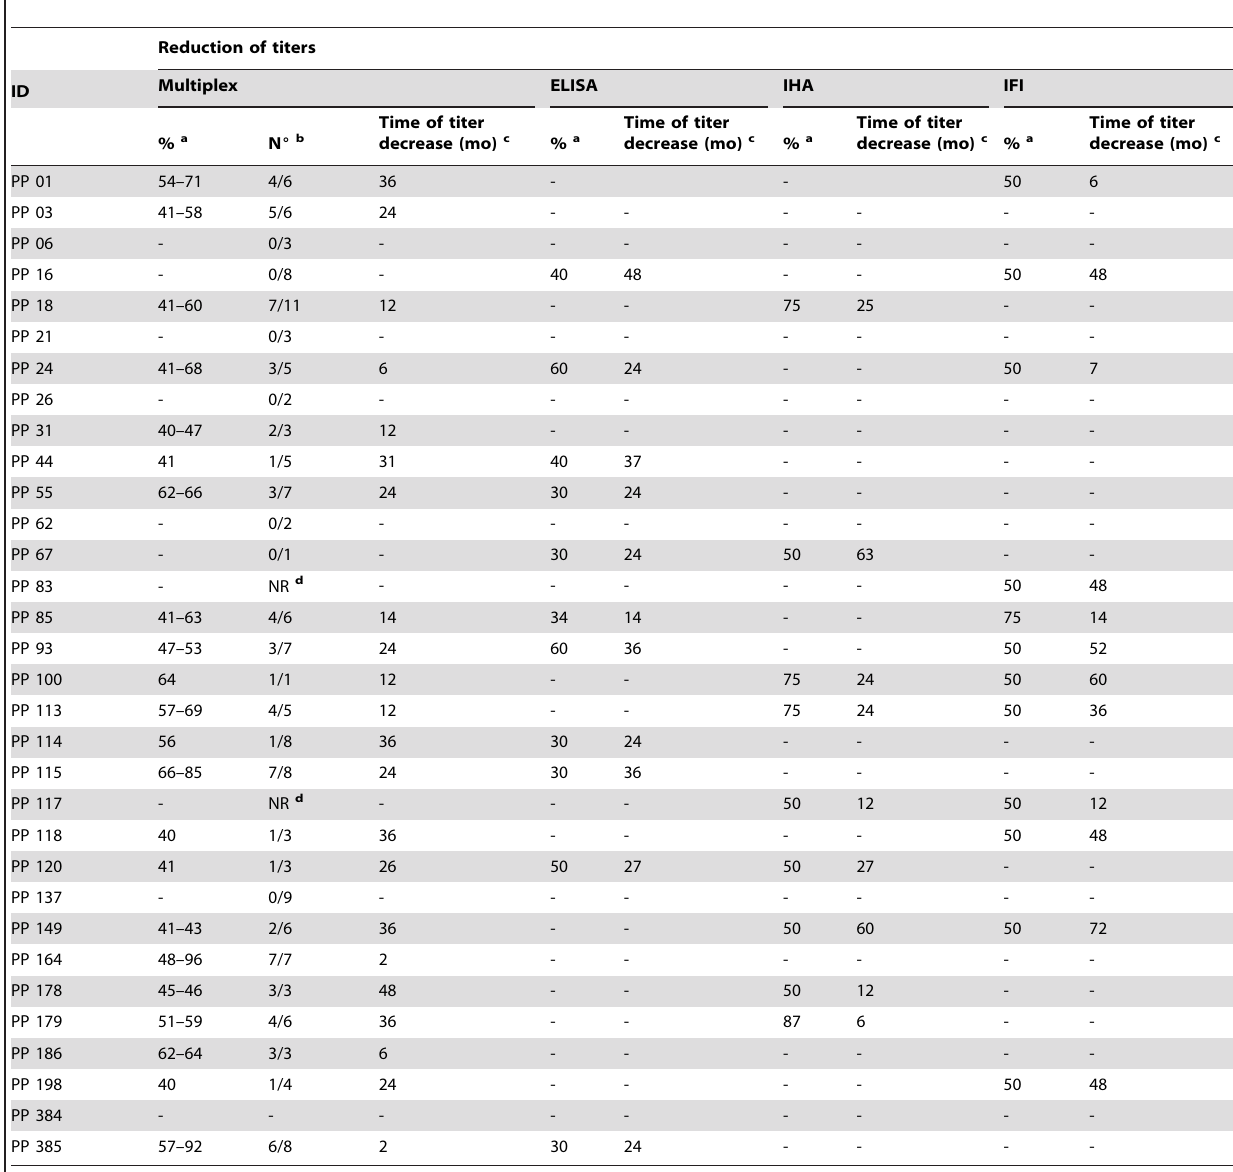
Table 3. Reduction of antibody levels by Multiplex and conventional serology after treatment with benznidazole.